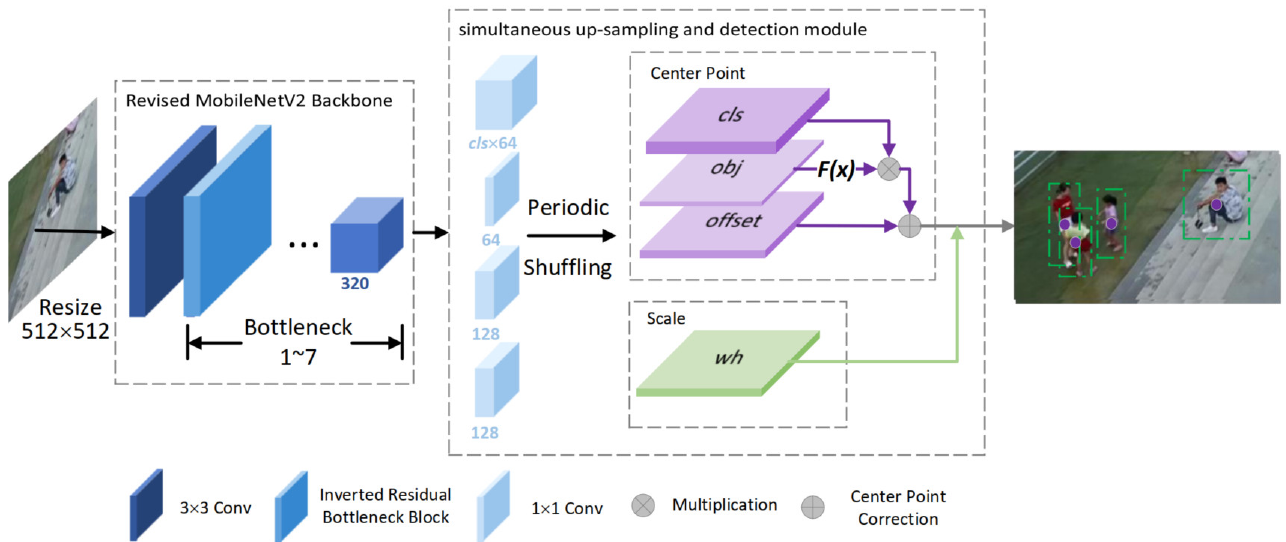
Figure 1. Visualization of our network architecture. Firstly, we resize the input image to fixed 512 × 512 resolution. Then, the resized image is fed into the revised MobileNetV2 backbone to obtain a feature map with 32 × down-sampling. Finally, the feature maps with a large receptive field are fed into the simultaneous up-sampling and detection module. Simultaneous up-sampling and detection module integrates the function of up-sampling and detection by using the sub-pixel convolution structure. As detection head, the structure has four branches—Multi-classification branch, objectness branch, and offset branch (in purple)—that are used to determine the center of the objects of interest. Scale branch (in green) is used to determine the scale of objects of interest, that is, width and